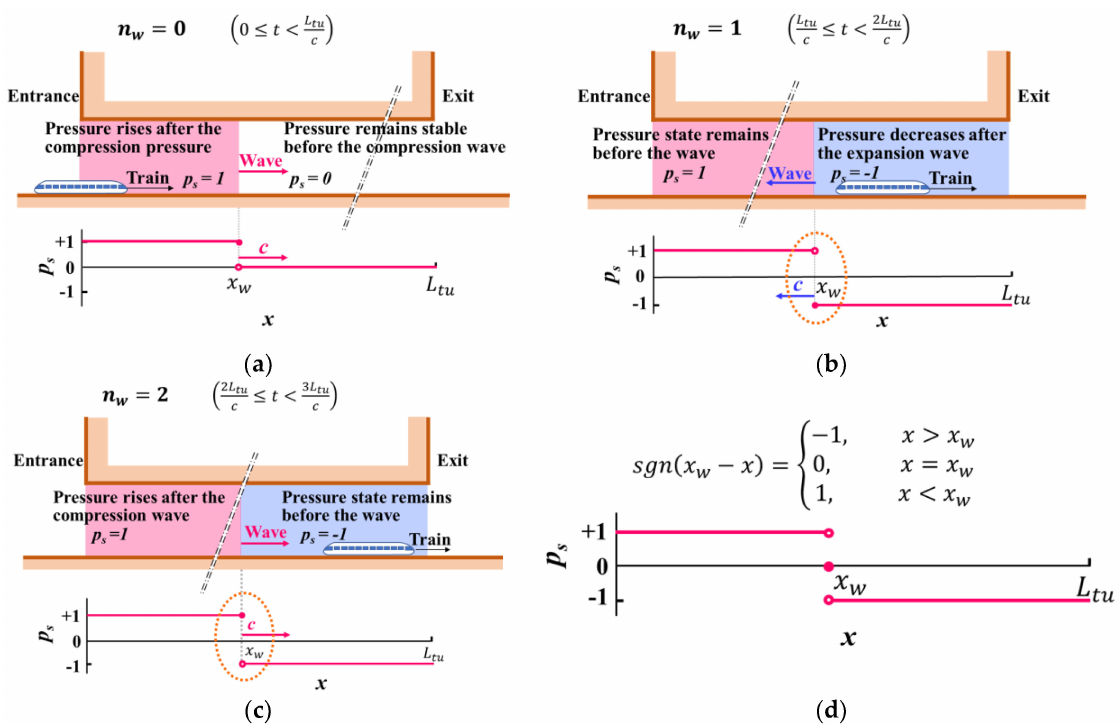
Figure 4. Schematic of pressure state distribution under different n w : ( a ) n w = 0, ( b ) n w = 1, ( c ) n w = 2, ( d ) Schematic of sign function ( n w : the reflected times of the wave at the tunnel port; p s : pressure state; x w : the location of pressure wave; L tu : tunnel length; c : the velocity of